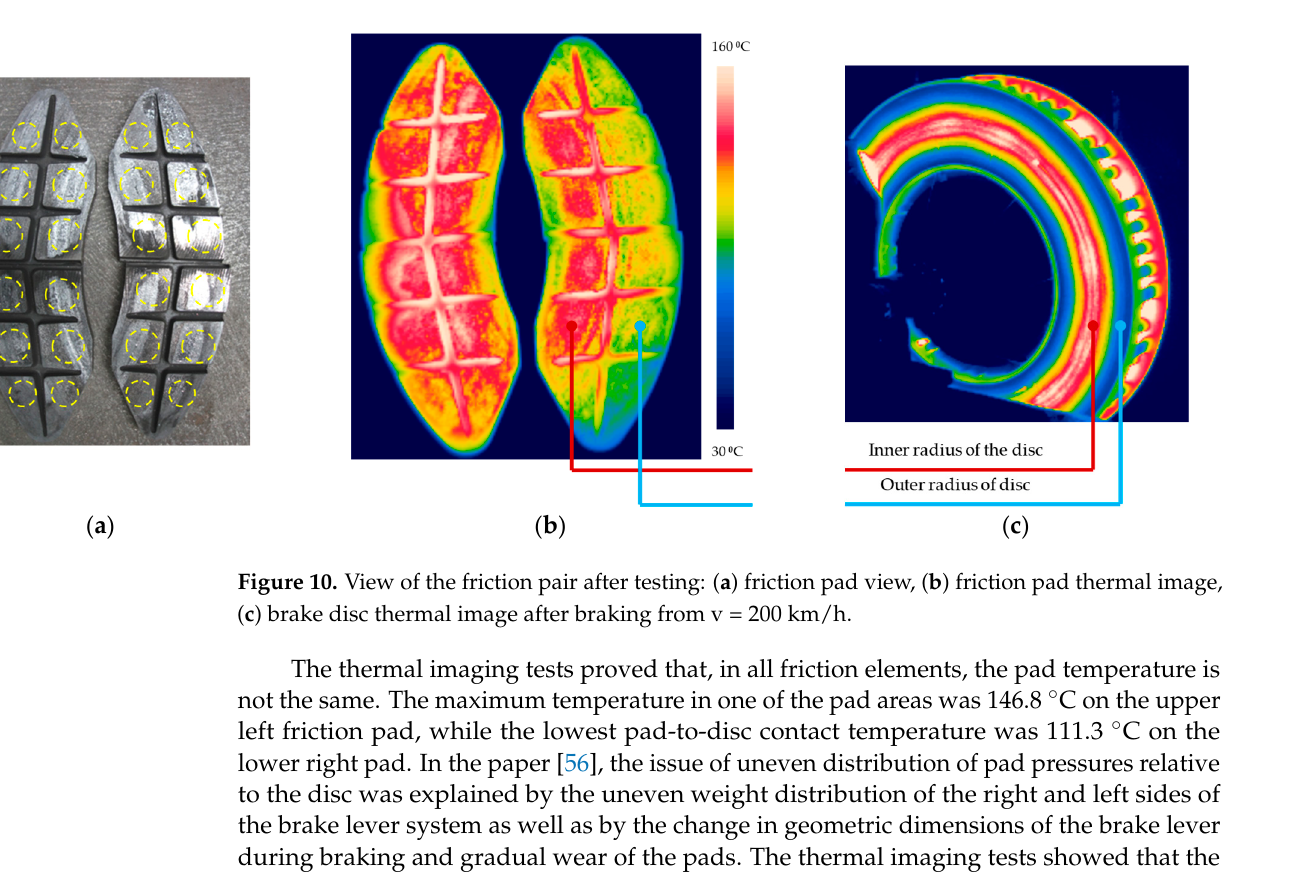
Figure 9. Histogram of relative error counts of the percentage fit of the multiple regression model of friction pad weight wear to test results.